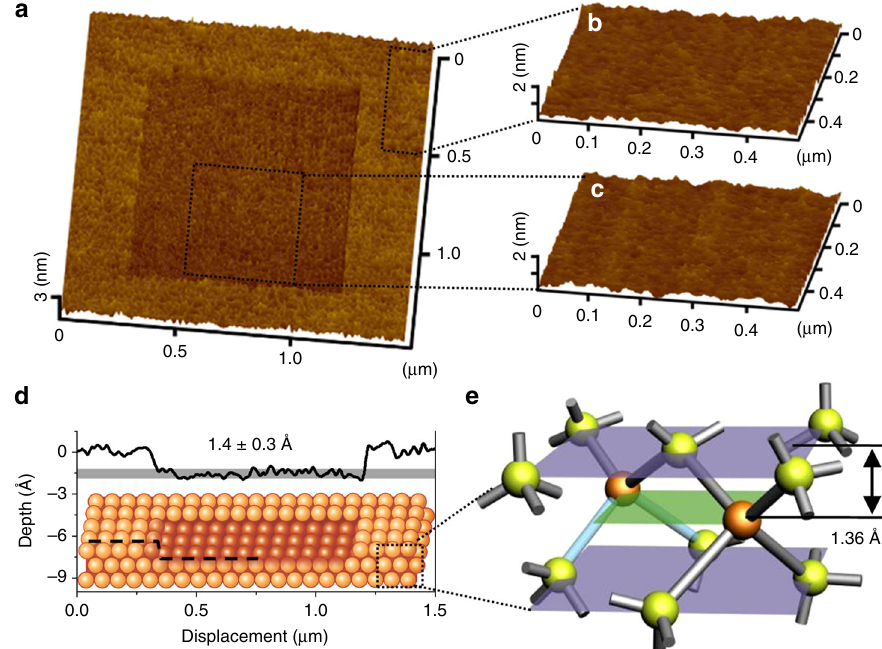
Fig. 1 Single atomic layer removal of Si material. a SPM image (1.5 µ m × 1.5 µ m) of the manufactured area. Topographic images (0.5 µ m × 0.5 µ m) of b the original surface, and c the manufactured surface. d Cross-section pro fi le of the manufactured area corresponding to the single atomic layer removal on Si (100). e Crystal structure of